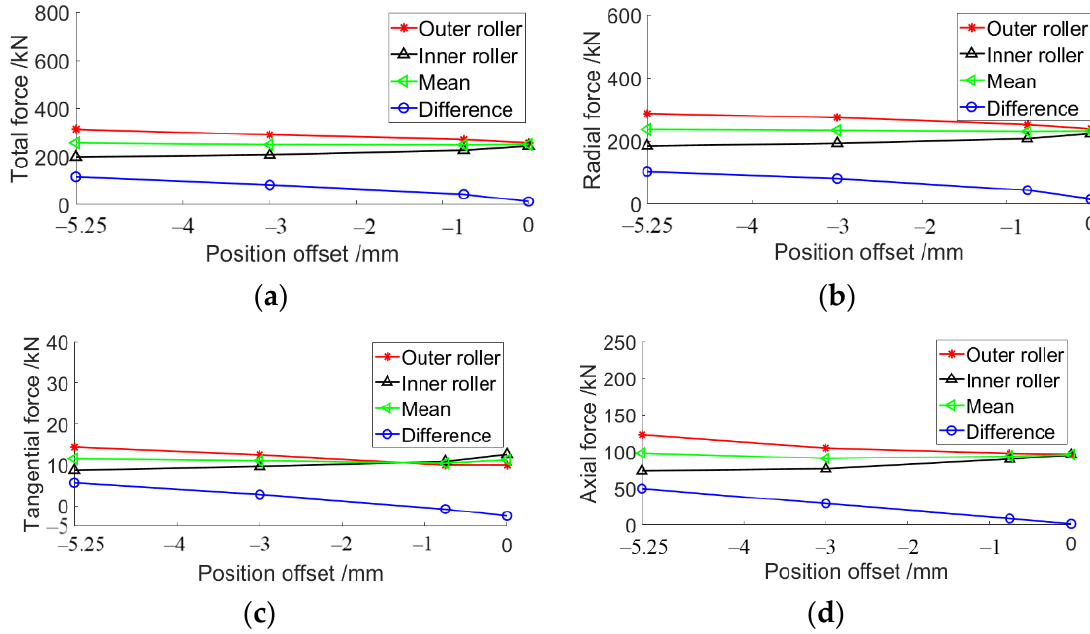
Figure 14. The influence of the rollers’ offset position on the flow -forming force: ( a ) Total force; ( b )